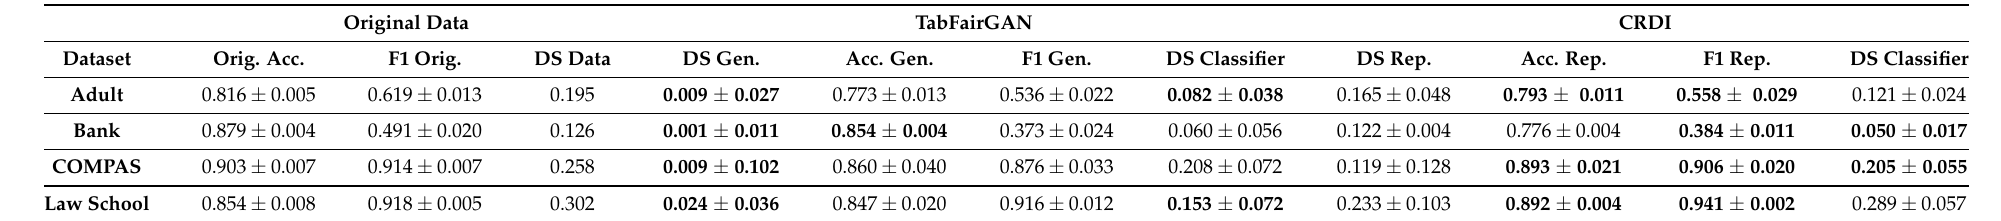
Table 2. Comparing the results of TabFairGAN for fair data generation with CRDI. Each number in the table reports the average and standard deviation over 5